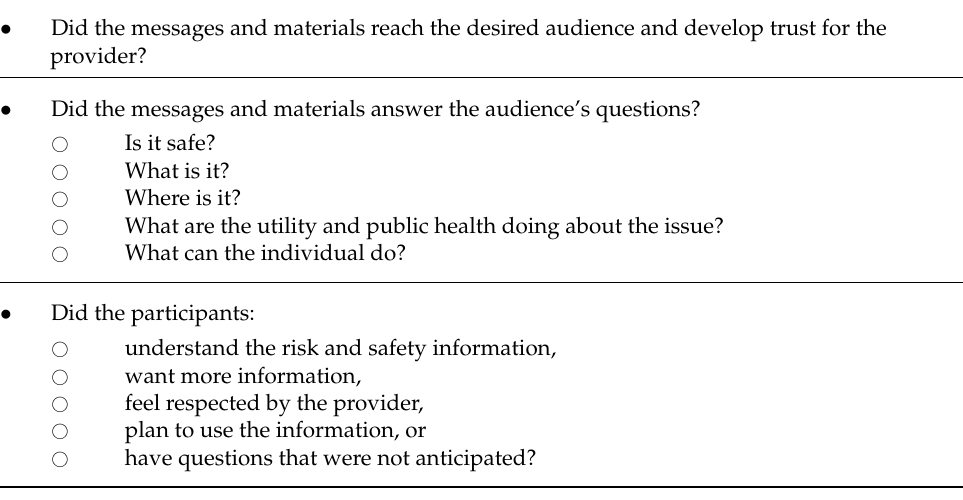
Table 6. Evaluation Questions for Risk and Safety Communication